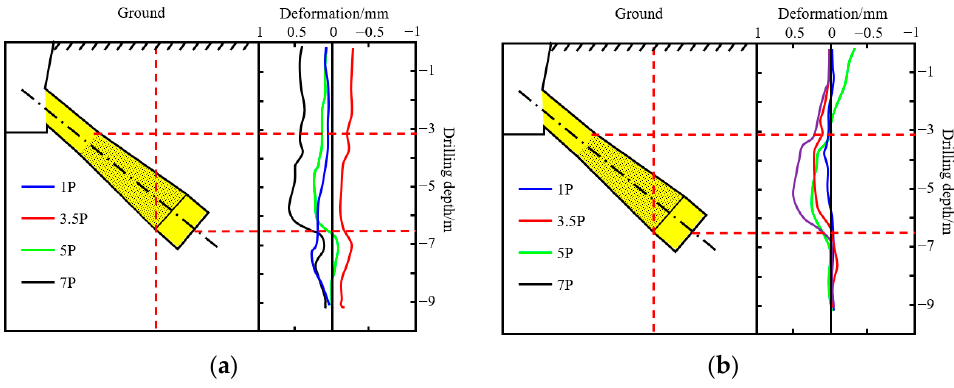
Figure 16. The cumulative curve of borehole depth–deformation: ( a ) C1 hole (back anchor surface); ( b ) C2 hole (front anchor surface).